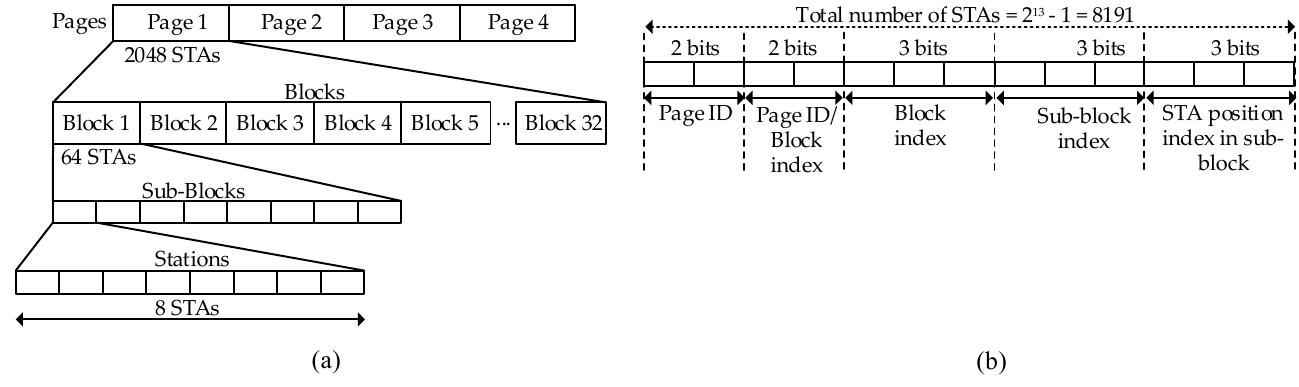
Figure 7. Association identifier (AID): ( a ) hierarchical structure of AID; ( b ) AID structure for STA. During the network deployment, the AP allocates AIDs to STAs based on (2), which illustrates how an AID ( A i ) is computed and how a slot is assigned to a specific STA during a communication [125].